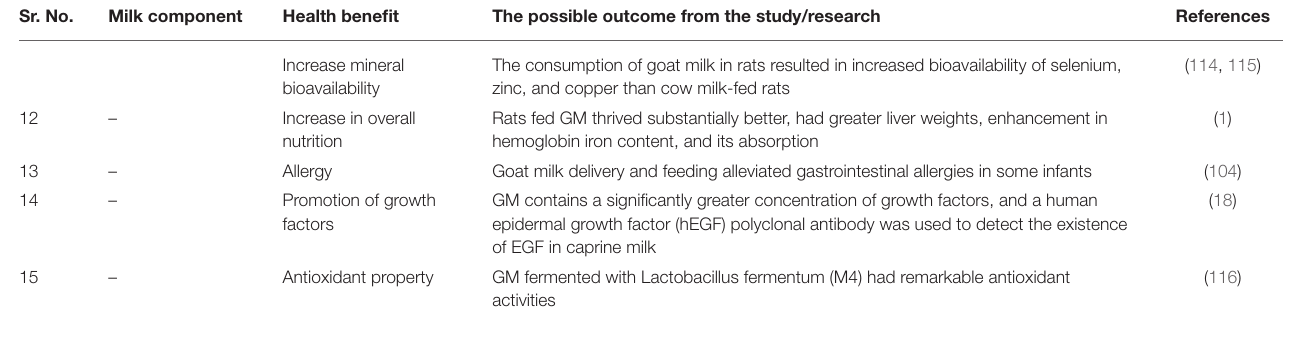
et al. observed a non-significant increased weight gain in infants ( N = 36), which were fed with infant formula based on goat milk than in those fed with infant formula based on cow milk, even though the study of both formulae had identical macronutrient and nutritional (energy) composition (117).